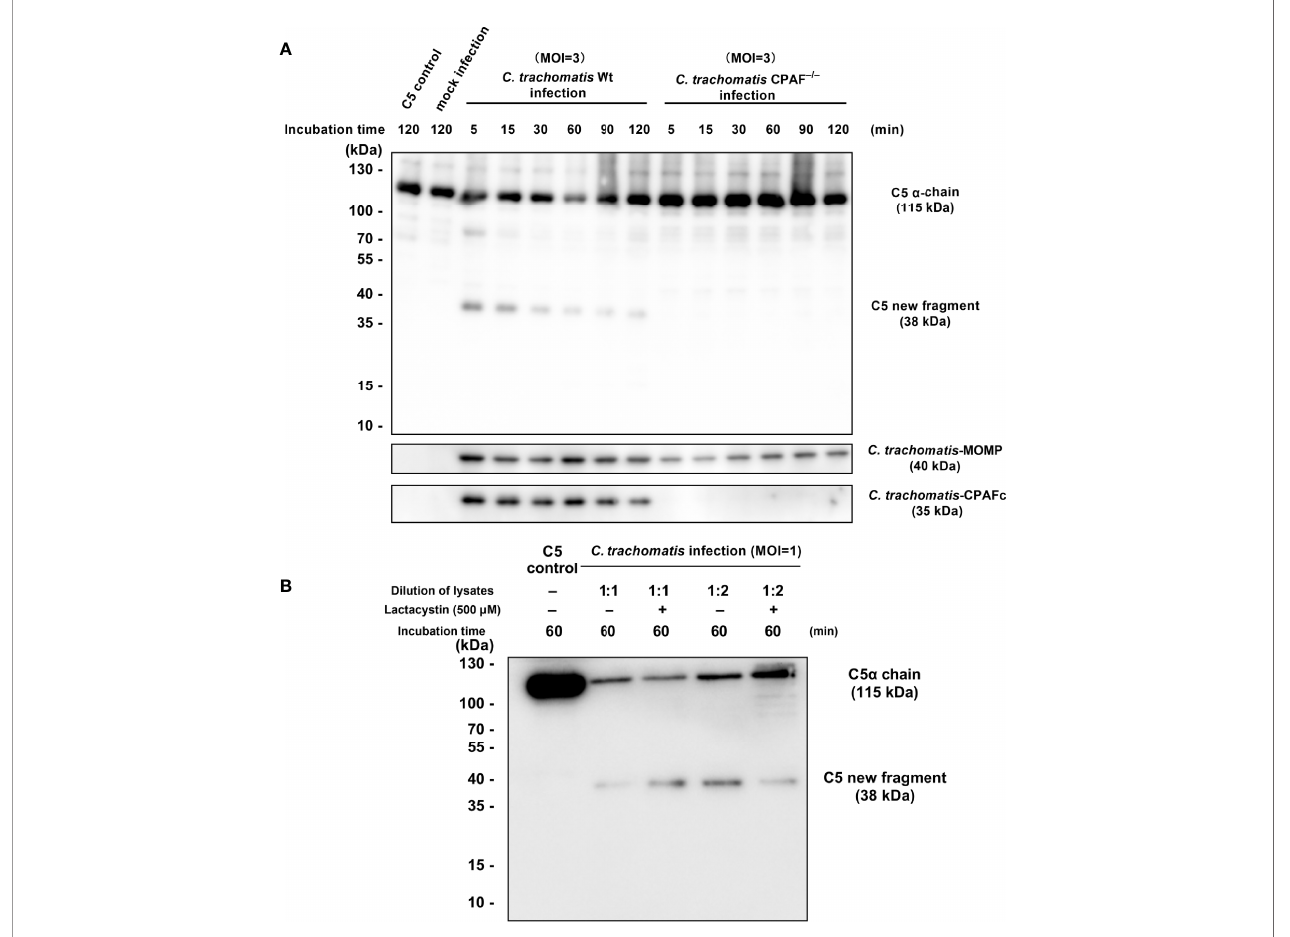
FIGURE 5 | CPAF induces a C5-derived novel fragment independent of C3. (A) Puri fi ed C5 was incubated with PBS, HeLa229 cells lysate, C . trachomatis -HeLa229 cells lysate, or C . trachomatis CPAF − / − -HeLa229 cells lysate, respectively. Products of the incubation were subjected to immunoblot analysis against C5a, MOMP, and CPAFc. (B) Lactacystin (500 m M) failed to inhibit C5 cleavage induced by 1:1 dilution of C. trachomatis -HeLa229 cell lysates, but slightly reduced consumption of the band corresponding to the C5 a chain (115 kDa) in the group of 1:2 dilution of C. trachomatis -HeLa229 cell